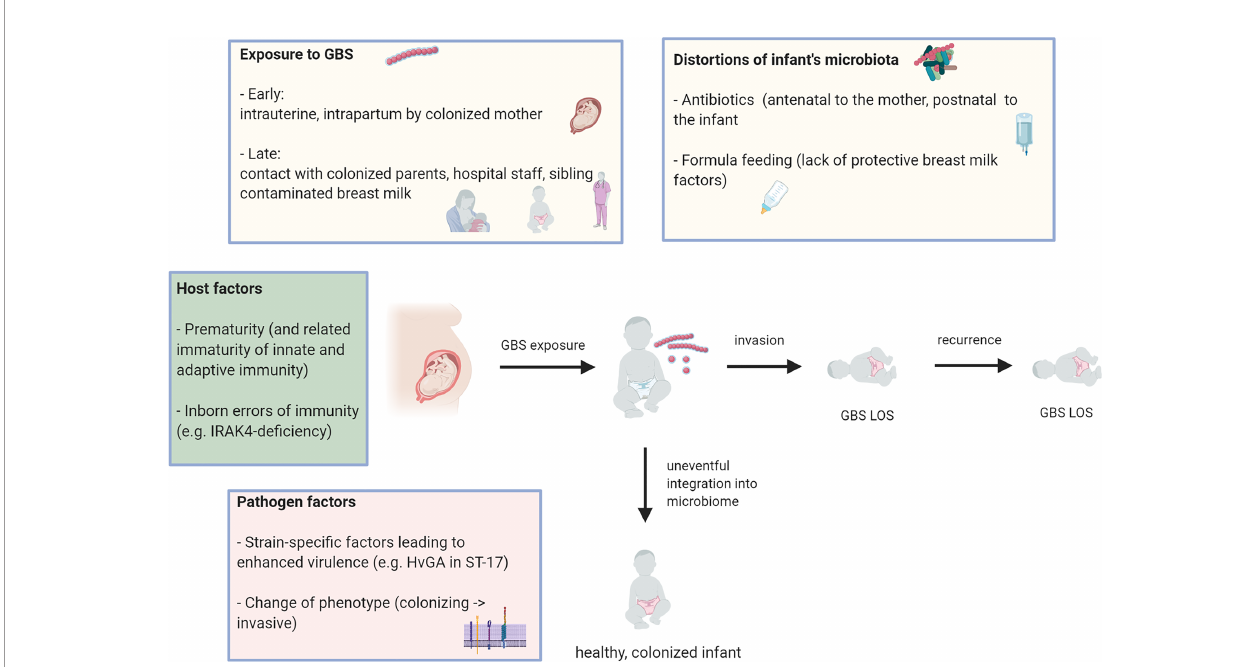
FIGURE 1 | Model of pathogenesis of (recurrent) Group B streptococcus late-onset disease. Several factors (boxes) impact on the outcome of postnatal contact of the neonate with GBS: uneventful integration into microbiome vs. invasive GBS infection (Figure was created using